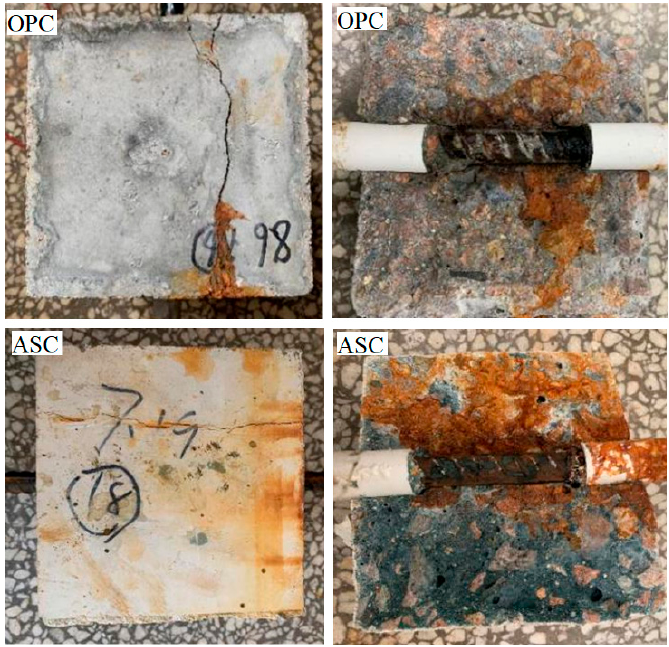
Figure 4. OPC and ASC corrosion cracking.